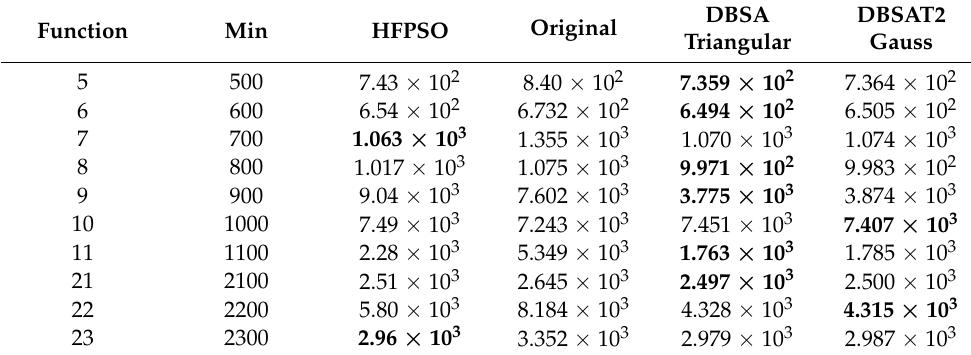
Table 6. Comparison with the HFPSO method.